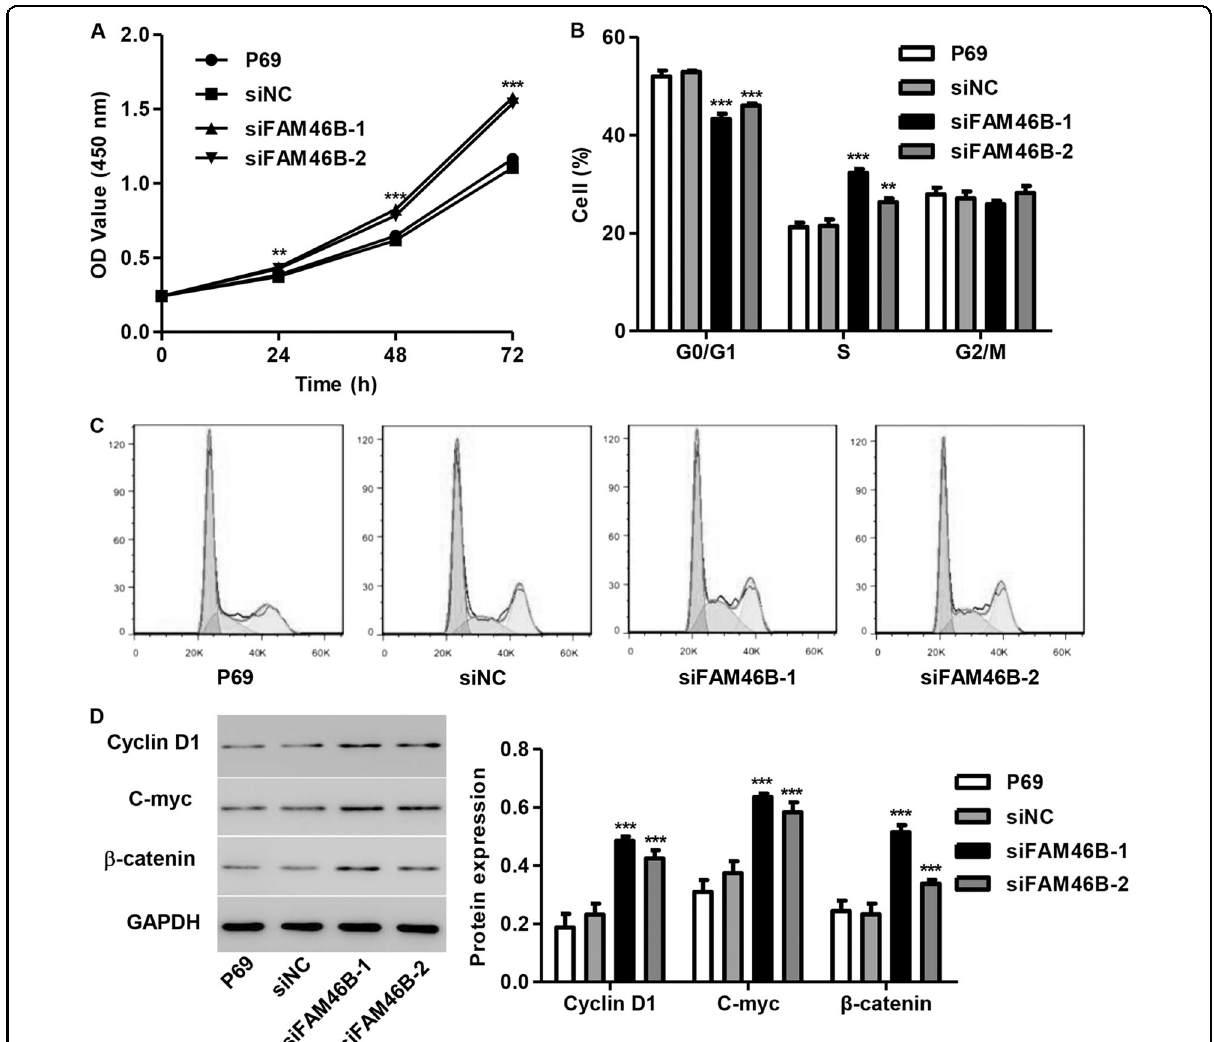
Fig. 3 FAM46B silencing promoted cell proliferation and cell cycle progression in P69 cells After P69 cells were transfected with siFAM46B-1 and siFAM46B-2, cell proliferation, cell cycle progression and the expression of C-myc, Cyclin D1, and β -catenin were measured by CCK-8 assay a , fl ow cytometry b , c , and western blotting d , respectively. ** P < 0.01, *** P < 0.001 compared with